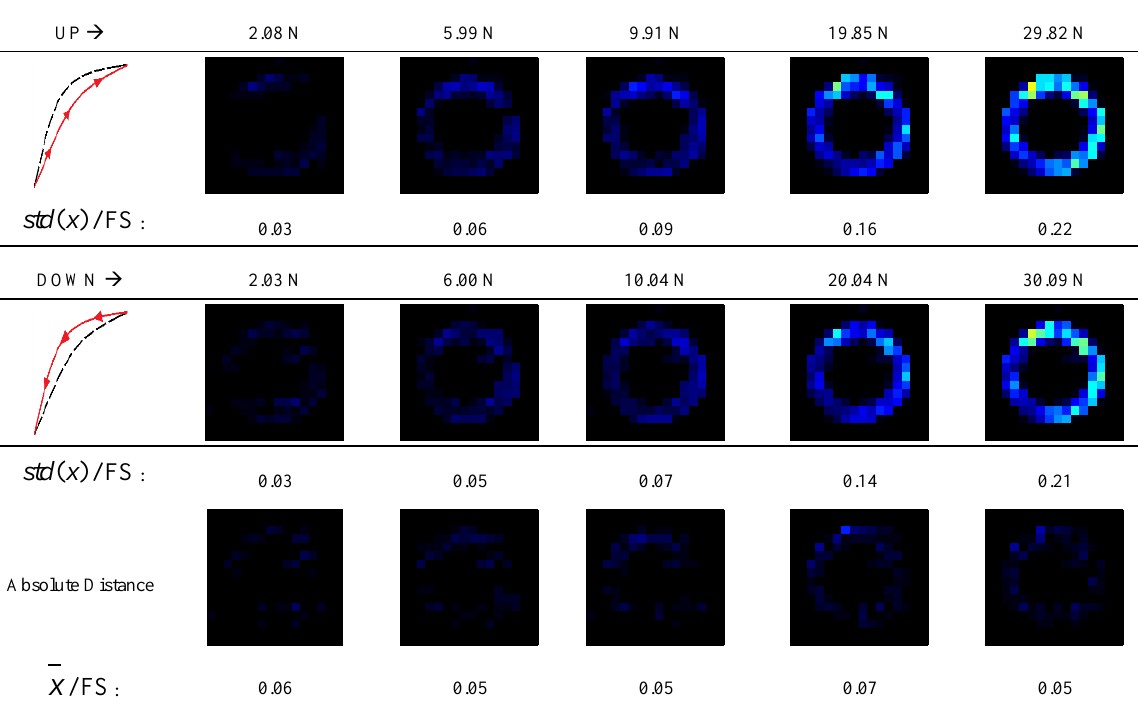
Table 9. Hysteresis loop frames with Ring object after compensation with ELAM